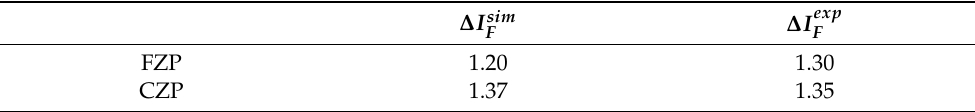
Table 4. Simulated and experimental focusing enhancement factors for both FZP and CZP